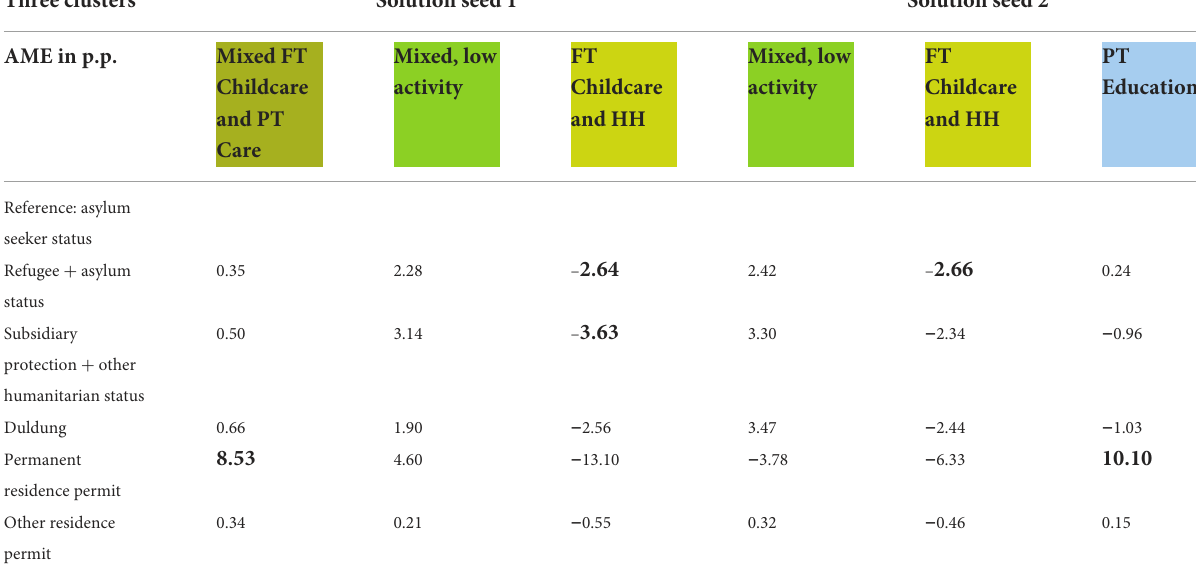
Mixed, low FT Mixed, low FT Childcare activity Childcare activity Childcare and PT and HH and HH